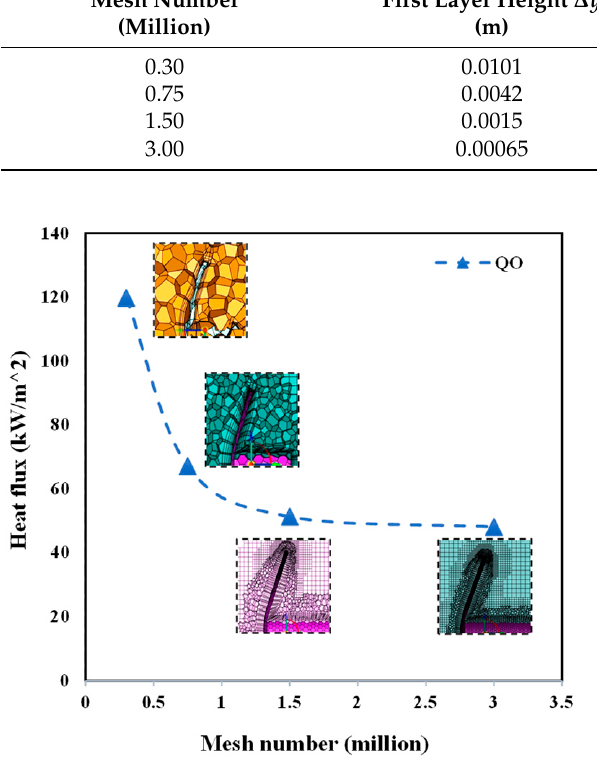
Figure 7. Temperature contours of the initial shape simulation; ( a ) translational rotation tempera- ture ( T tr ); ( b ) vibratory electron temperature ( T ve ).